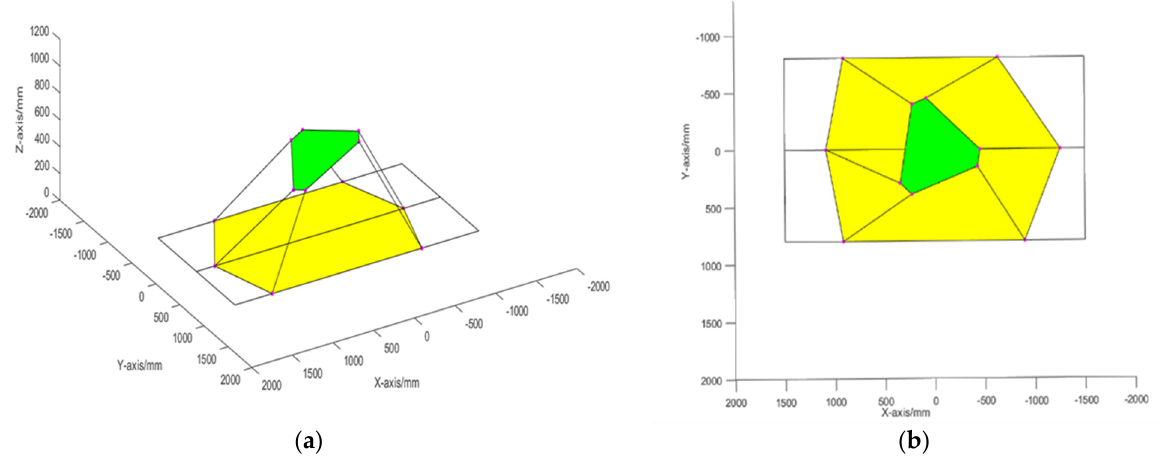
Figure 8. Pose of the robot when the yaw angle = 20 degrees. ( a , b ) show the results from different perspectives.